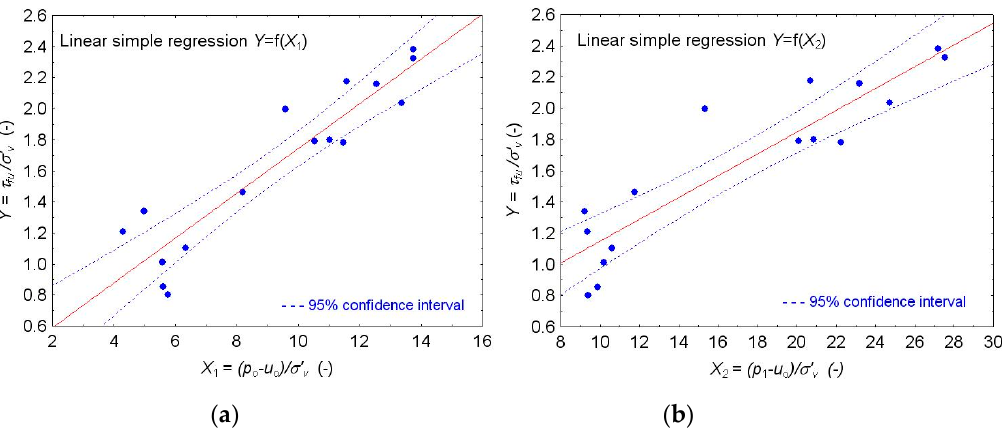
Figure 8. Linear simple regression models with 95% confidence intervals: ( a ) Y = f(X1), ( b ) Y = f(X2).